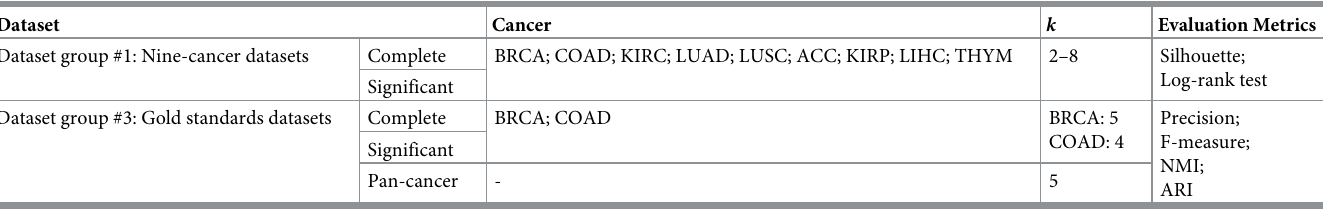
Table 3. Testing strategies and the datasets of the accuracy tests.